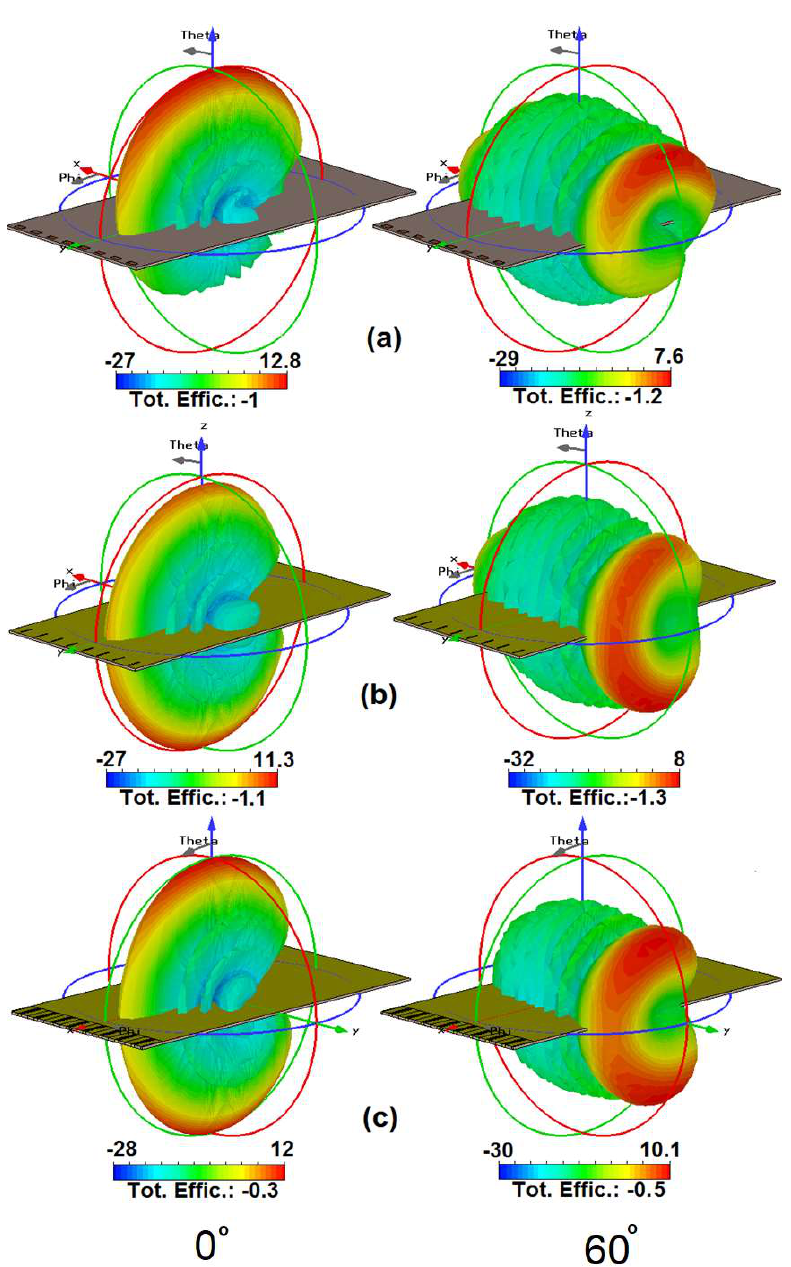
Figure 16. Three-dimensional radiation beams of the antennas are shown in Figure 8 and the proposed design.